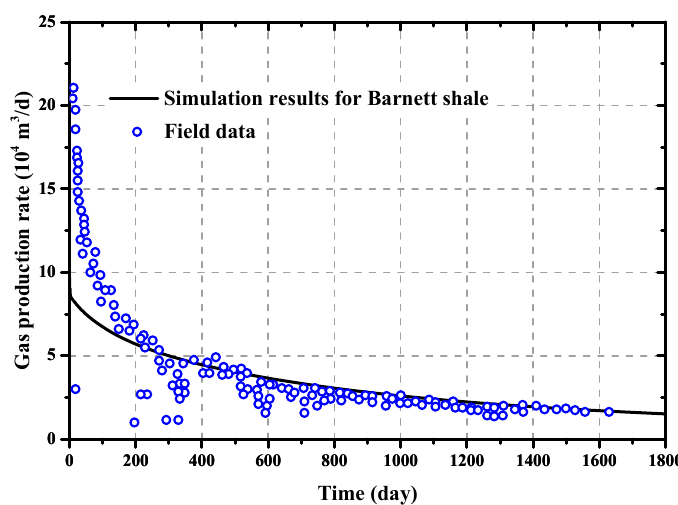
Figure 6. Comparison between our simulation results and the field data from the Barnett shale well.